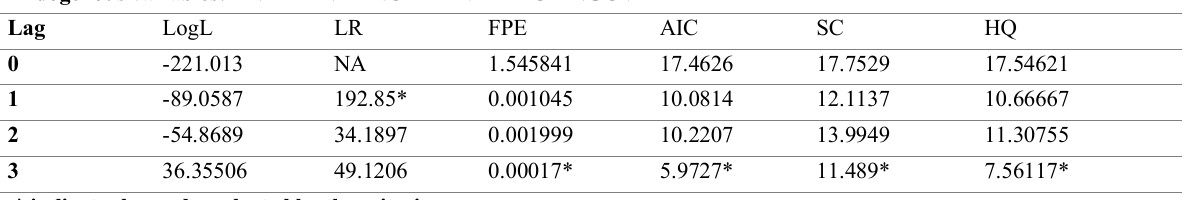
Table 3: VAR Lag Order Selection